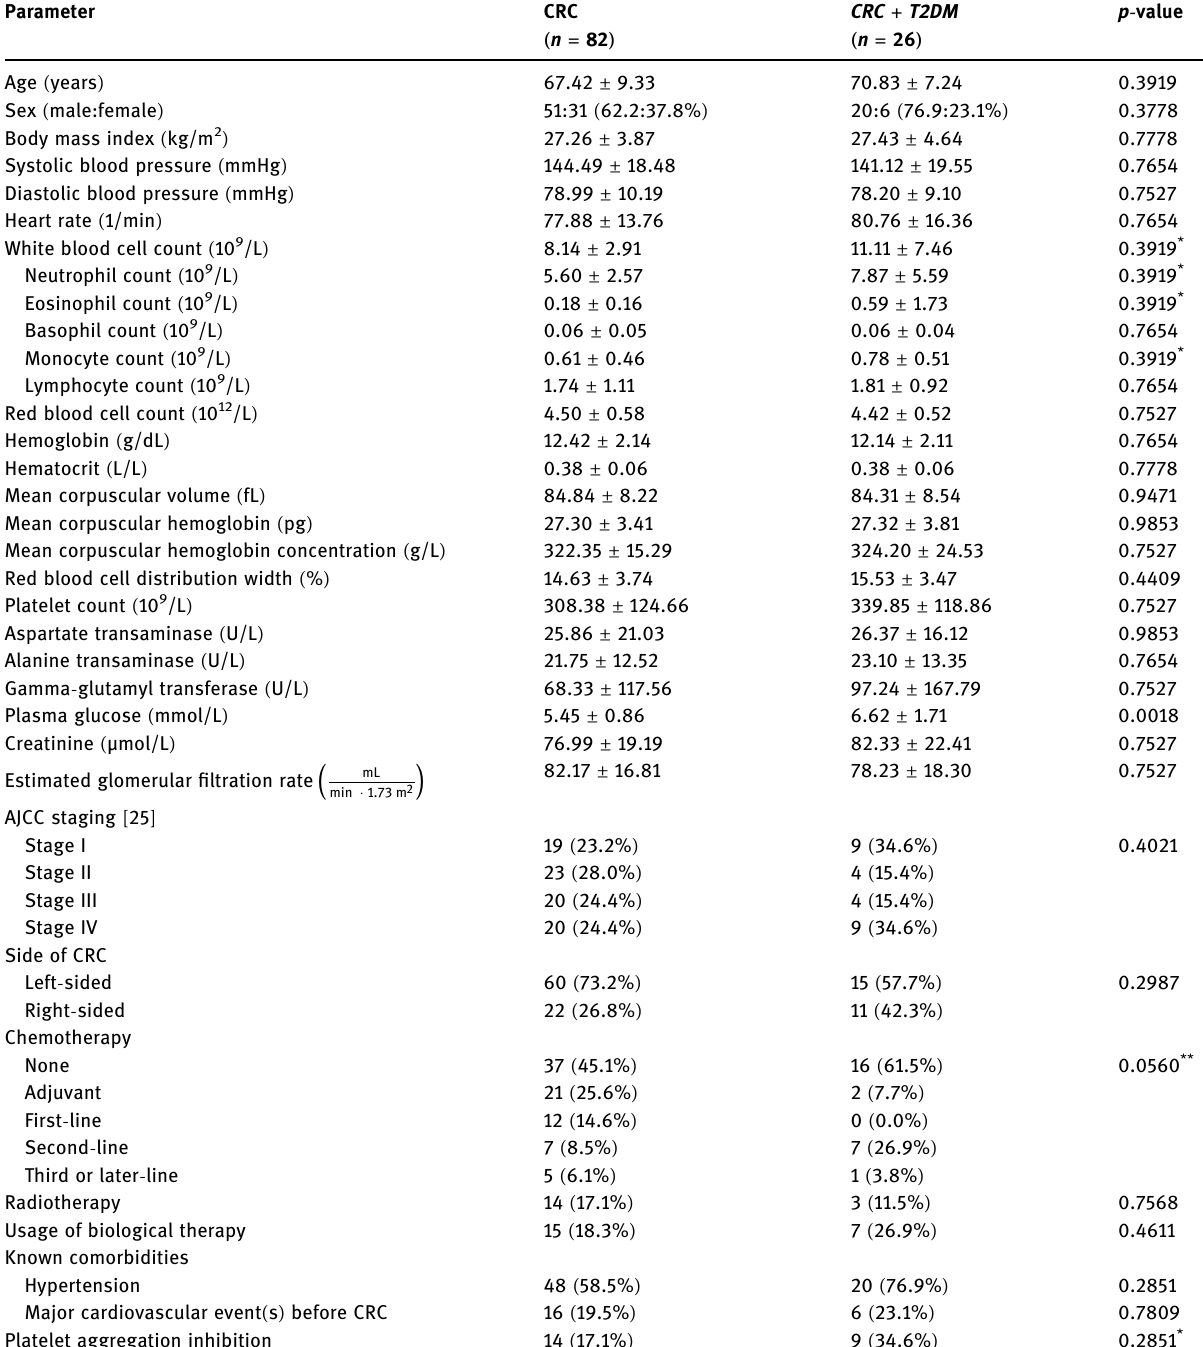
Table 1: Metabolic, clinical, and other parameters of CRC patients